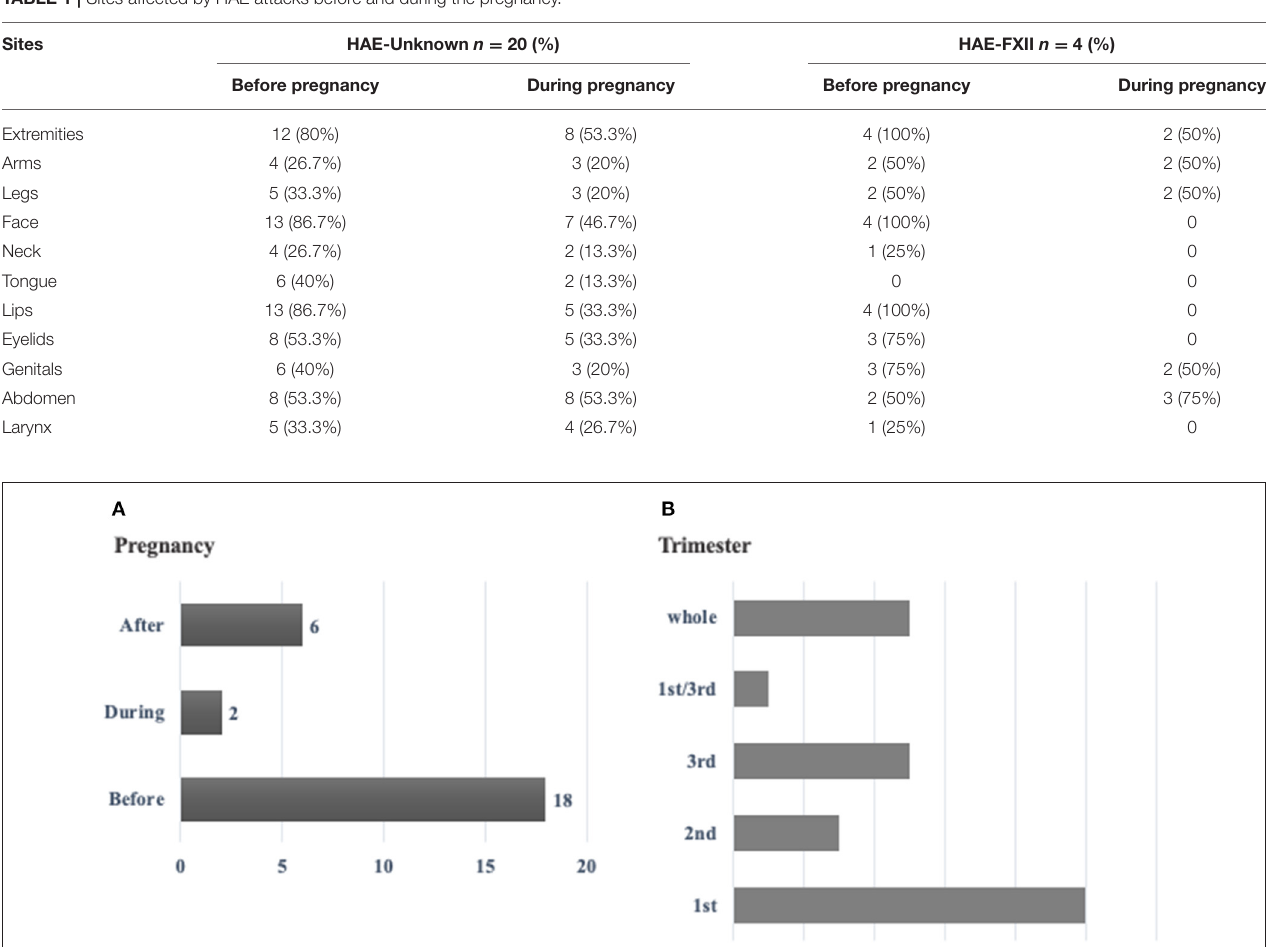
TABLE 1 | Sites affected by HAE attacks before and during the pregnancy. Sites